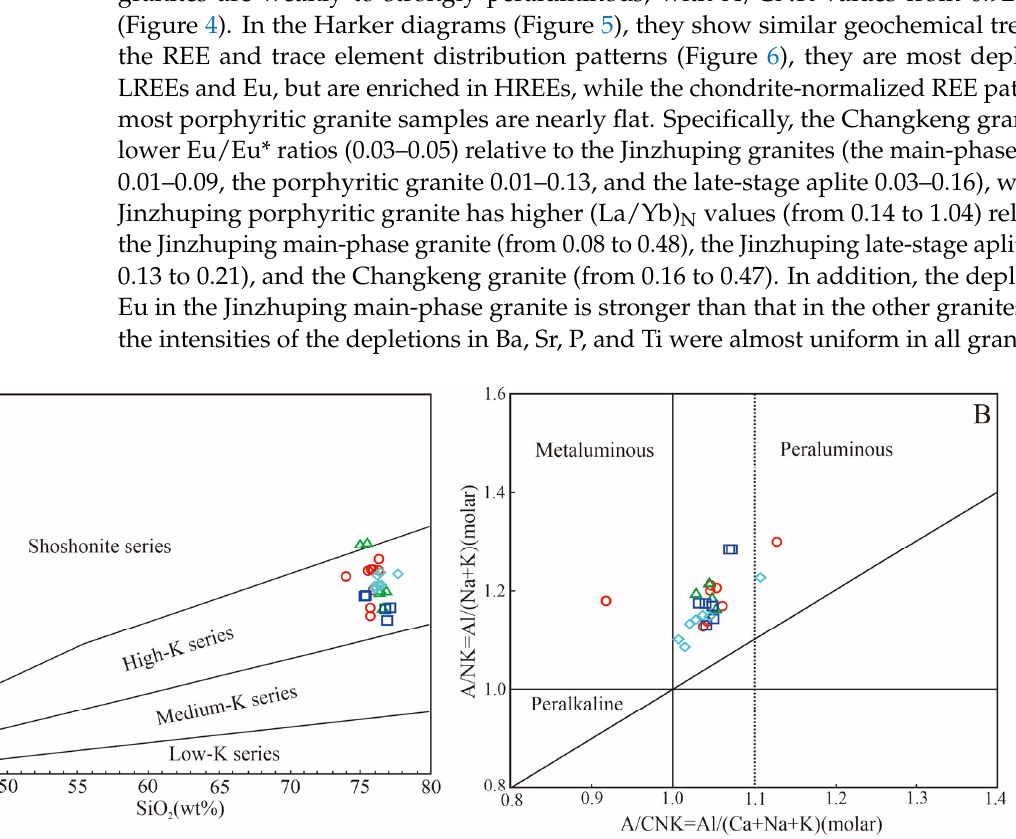
Figure 5. Harker diagrams for the Helong granites. Symbols as in Figure 4.